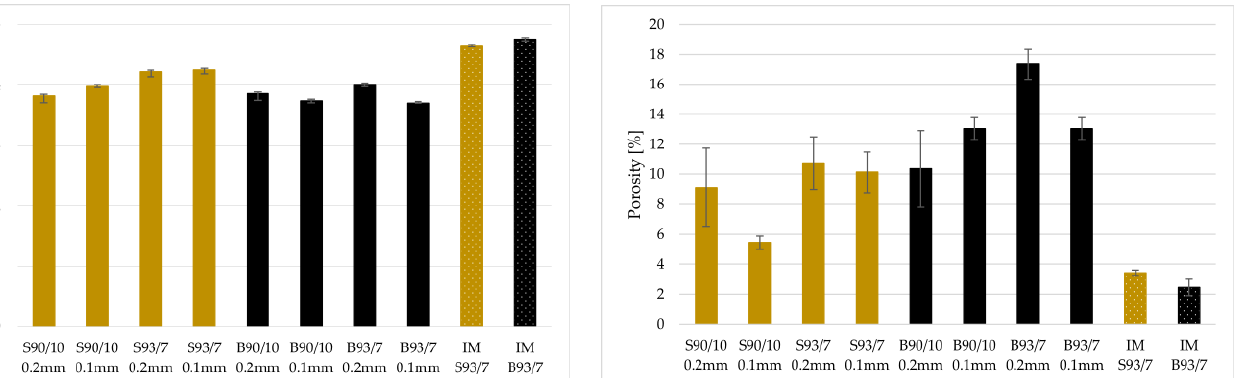
Figure 7 . Bar charts of density and calculated porosity of FDM-printed magnets, with various filler loadings and printing heights, and injection-moulded magnets.